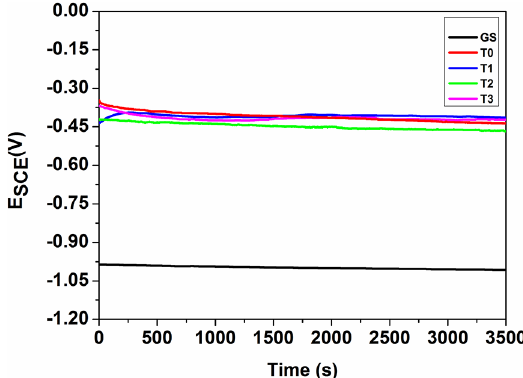
Figure 8. Open-circuit potential (E 0.05 mol.L –1 NaCl solution.